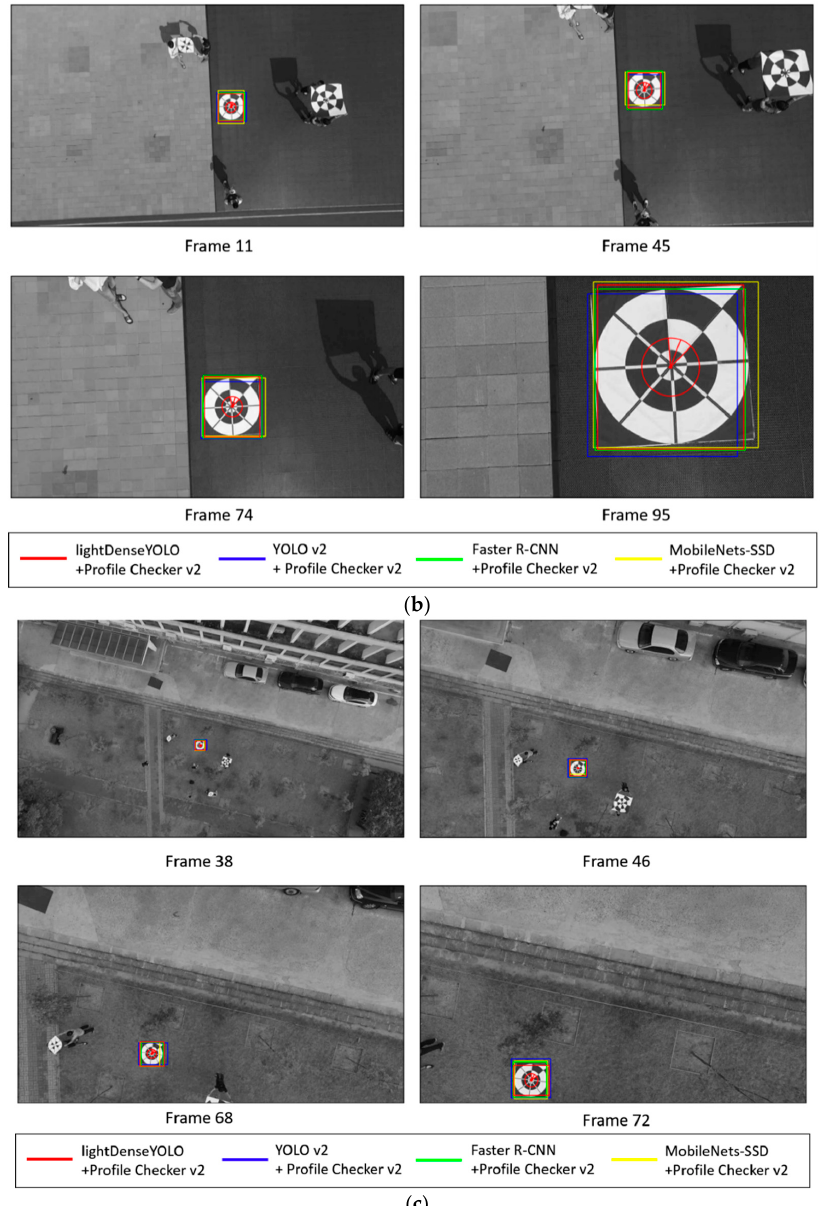
Figure 21. Marker detection example obtained using our method and previous methods in the ( a ) morning; ( b ) afternoon; and ( c )